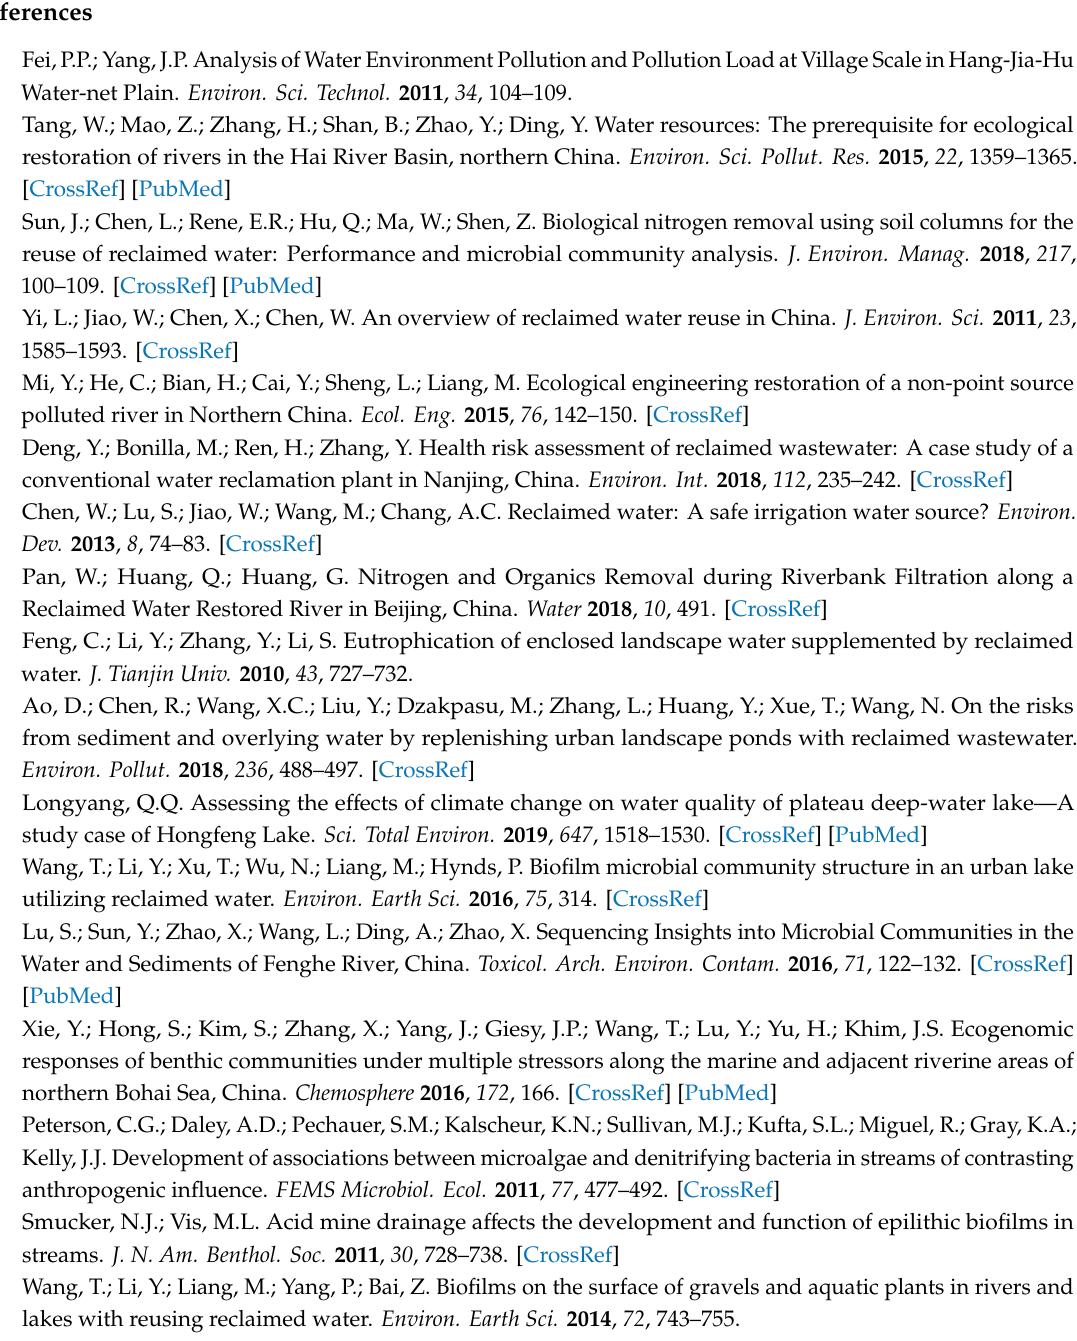
Table S1: Sample name and description, Figure S1: Rarefaction curve of water and biofilm